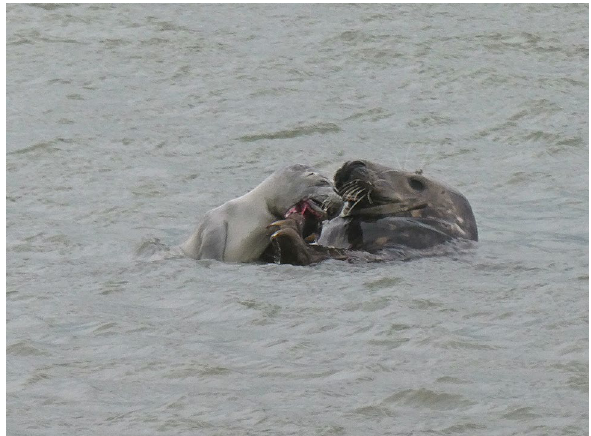
Figure 4. Subadult grey seal bull with a juvenile harbour seal as prey and shown while inducing the typical helical lacerations by tearing apart the tissue using its pectoral flipper and jaws. Helgoland, October 2017. Picture courtesy of Susanne Hauswaldt.